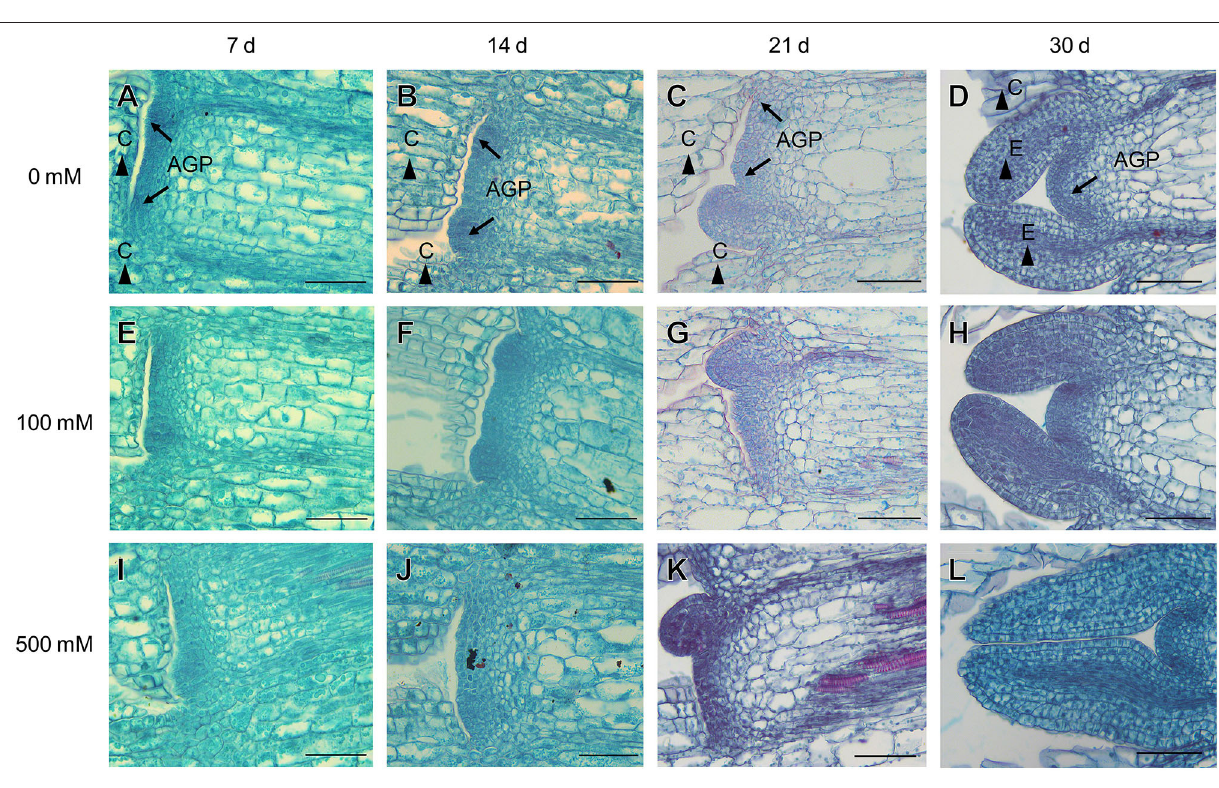
Frontiers in Plant Science |